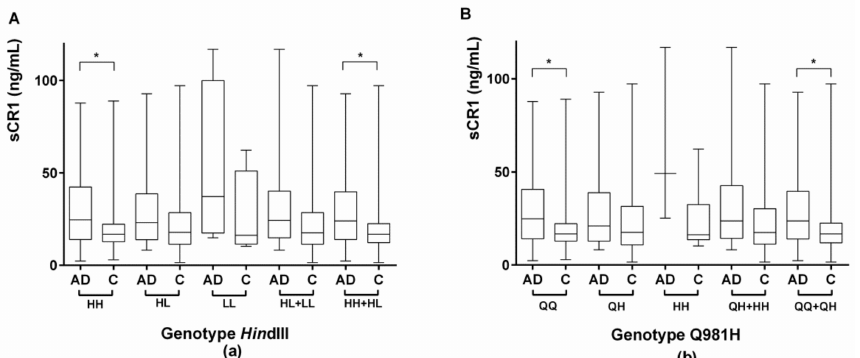
Figure 3. Comparison of sCR1 levels according to CR1 density polymorphisms, Hin dIII and Q981H (genotype), among AD patients and controls. Box plots of sCR1 are shown. The upper and lower limits of the boxes, and the middle line across the boxes indicate the 75th and 25th percentiles, and the median, respectively. The upper and lower horizontal bars indicate the maximum and minimum values, respectively. A Student’s t -test was used to compare AD patients with controls according to CR1 density polymorphisms for normally distributed variables; * p < 0.005; sCR1 = soluble CR1. ( a ) Comparison of sCR1 levels according to Hin dIII polymorphisms in AD patients and controls. HH = individuals homozygous for the H allele ( Hin dIII polymorphism); HL = individuals heterozygous for the Hin dIII polymorphism; LL = individuals homozygous for the L allele ( Hin dIII polymorphism). ( b ) Comparison of sCR1 levels according to Q981H polymorphisms in AD patients and controls. QQ = individuals homozygous for the Q allele (Q981H polymorphism); QH = individuals heterozygous for the Q981H polymorphism; HH = individuals homozygous for the H allele (Q981H